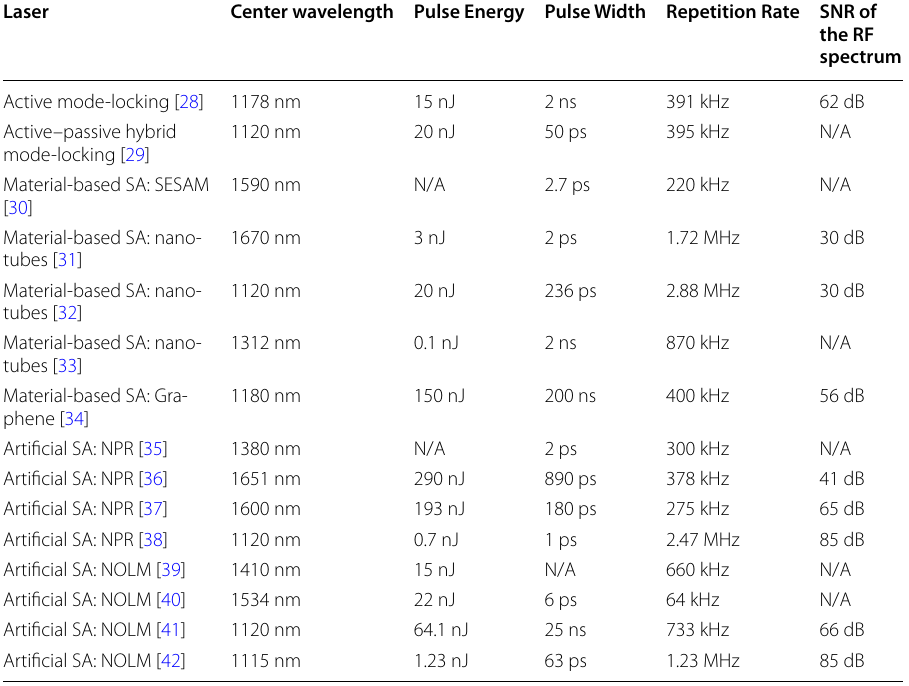
the RF spectrum